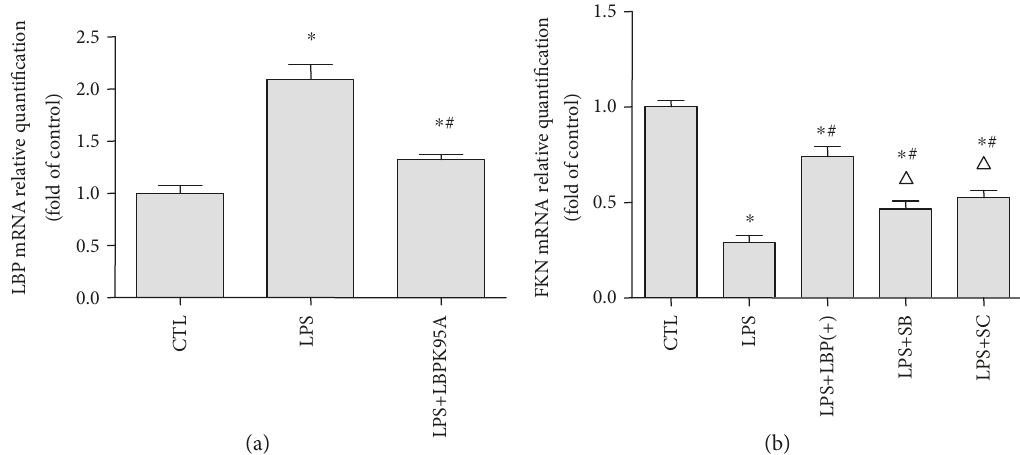
Figure 5: Expression of LBP and FKN mRNA in ARDS rat lung homogenates. The lung tissue was homogenized by sonicating in RIPA bu ff er. Total RNA of lung homogenates was isolated using chloroform, and the protocol of TRIzol kit was used according to the manufacturer ’ s instructions. RT-PCR was used to analyze the LBP and FKN mRNA expression in ARDS rat lung tissues. The results suggest that LBPK95A, SB203580, and SC-514 suppressed the LPS-induced FKN reduction. ∗ represents p < 0 05 when compared with that in the CTL group rats; # represents p < 0 05 when compared with that in the LPS group rats; △ represents p < 0 05 when compared with that in the LPS+LBPK95A rats ( n = 10